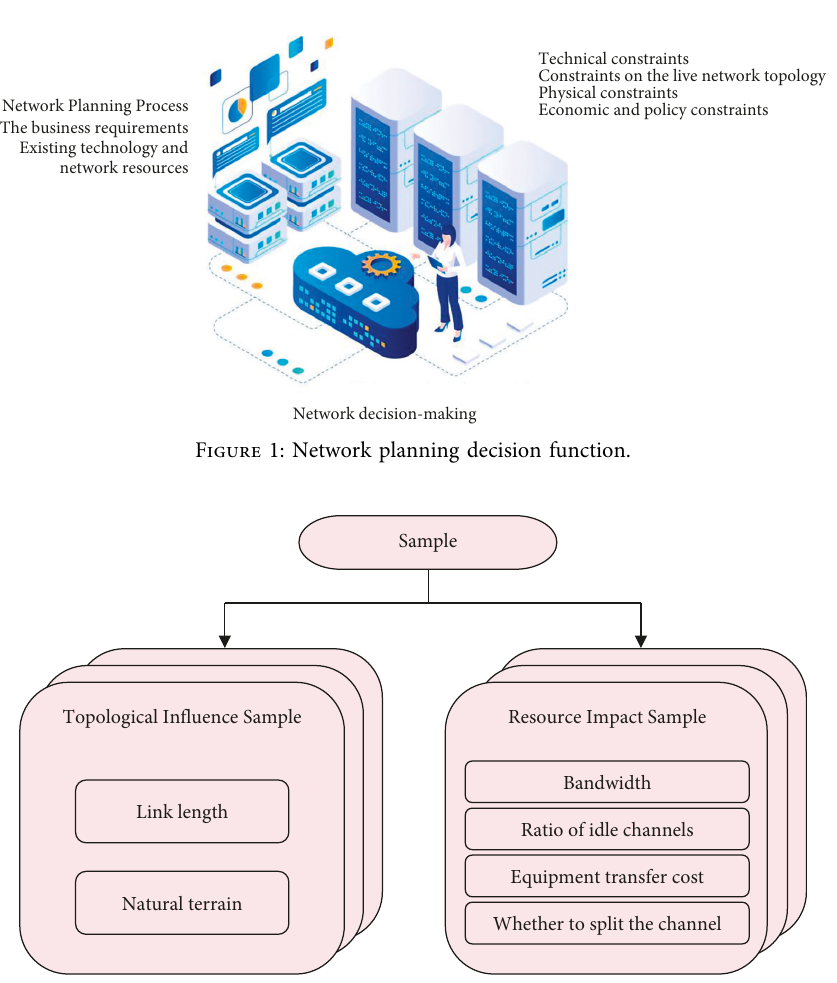
Figure 2: Composition of sample